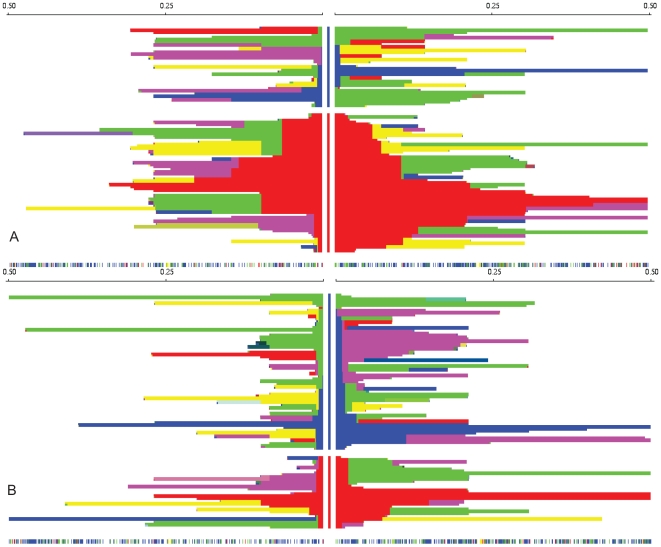
Haplotype decay around rs11724320 in Europeans and Africans.Figure 8a shows the haplotype decay in genomic region of 1Mb around rs11724320, located in the NPY1R/NPY5R region, in 90 Utah residents with Northern and Western European ancestry from the CEPH collection (European HapMap individuals). Each horizontal line represents a haplotype and the center column represents the core SNP rs11724320 with the derived C-allele in red and the ancestral T-allele in blue. The derived C allele of rs11724320is positioned on an unusually long haplotype compared to the ancestral T allele in the European HapMap individuals. Figure 8b shows the haplotype decay in genomic region of 1Mb around rs11724320, located in the NPY1R/NPY5R region, in 90 YRI Yoruba in Ibadan from Nigeria (African HapMap individuals). The haplotype lengths around the derived C allele and the ancestral T allele of rs11724320 do not significantly differ in the African population.